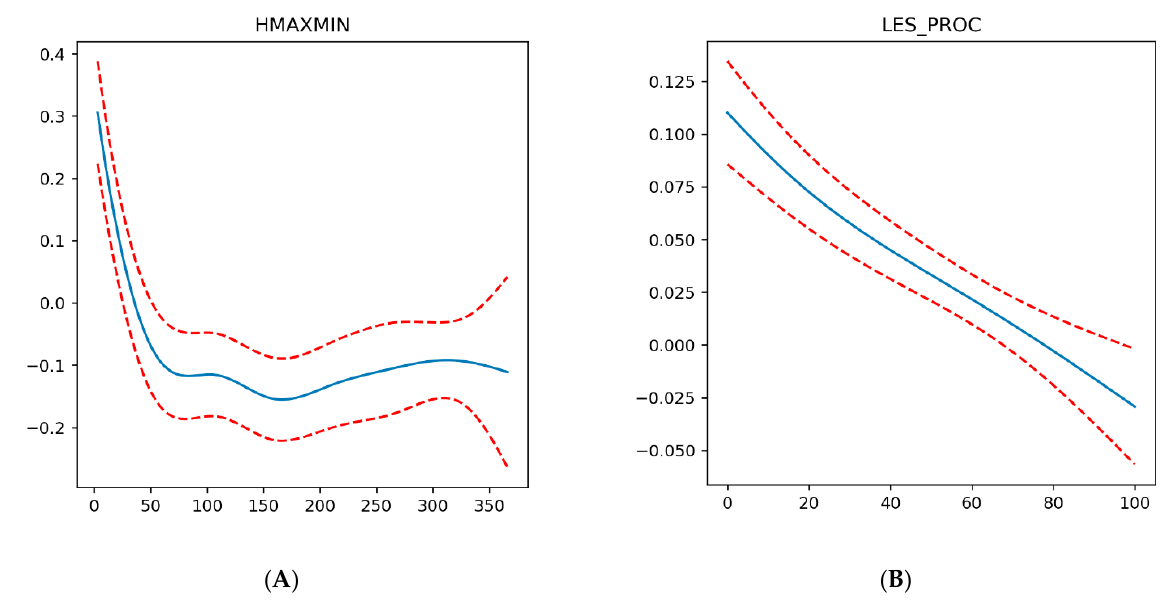
Figure 13. Dependence of rill erosion density on elevation range (m) ( A ) and average forest cover (%) ( B ) in the basin.